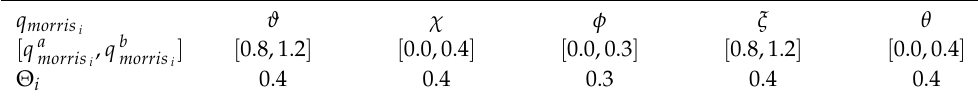
Table 2. Parameter variation values for the Morris